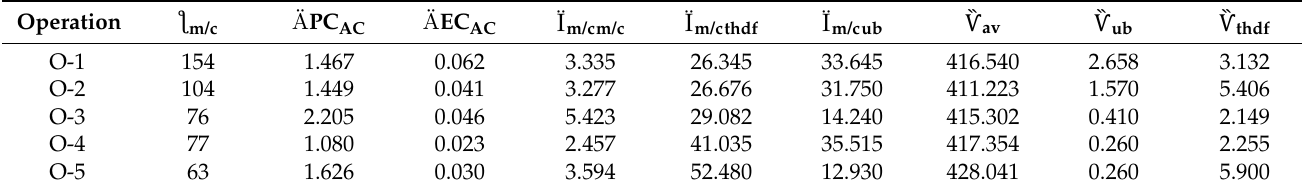
Table 5. Experimental observations and calculations of air cutting (without machining).